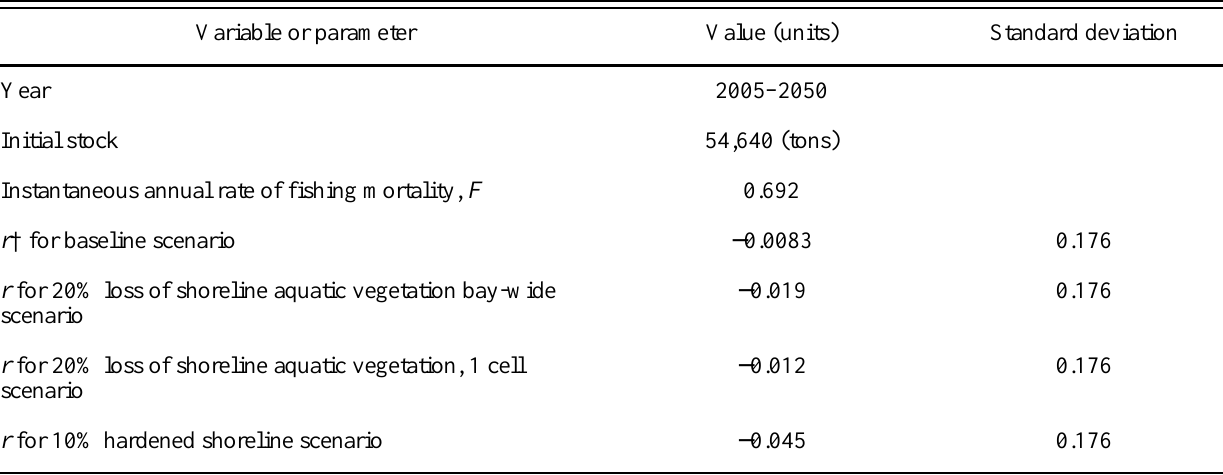
Table 4. Values of variables and parameters used to simulate blue crab stock and landings for forecast